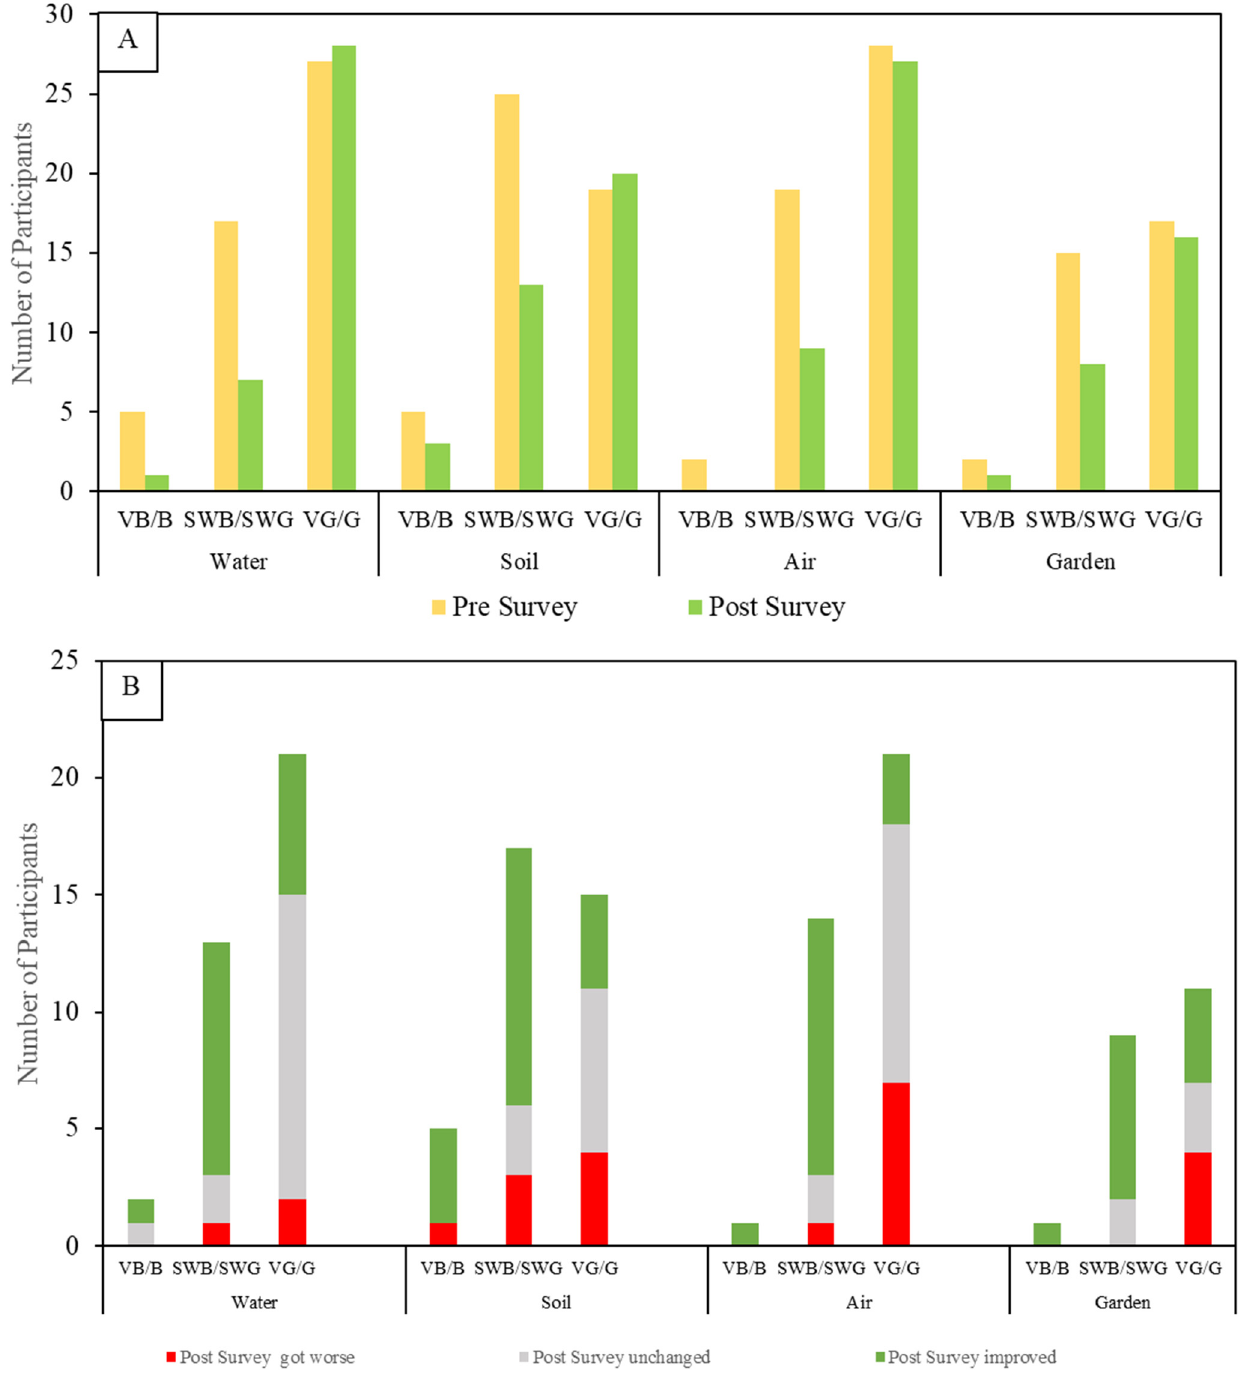
Figure 8. Three-way perception analysis. ( A ) tracking changes in perceptions of environmental health concerns before and after intervention. ( B ) rating change analysis (positive, remained same or negative). It should be noted that post-intervention, only 73% of participants participated. VB/B: very bad or bad; SWB/SWG: somewhat bad or somewhat good, VG/G: very good or good. To explore the changes in initial perceptions after sharing environmental information about their homes, the percentages of respondents whose ratings improved, stayed the same, and got worse gives some insight into the ways the information received affected residents’ perceptions (Figure 8B). Several insights emerge from Figure 8B: most of the instances of resident ratings getting more negative by a point or more after seeing